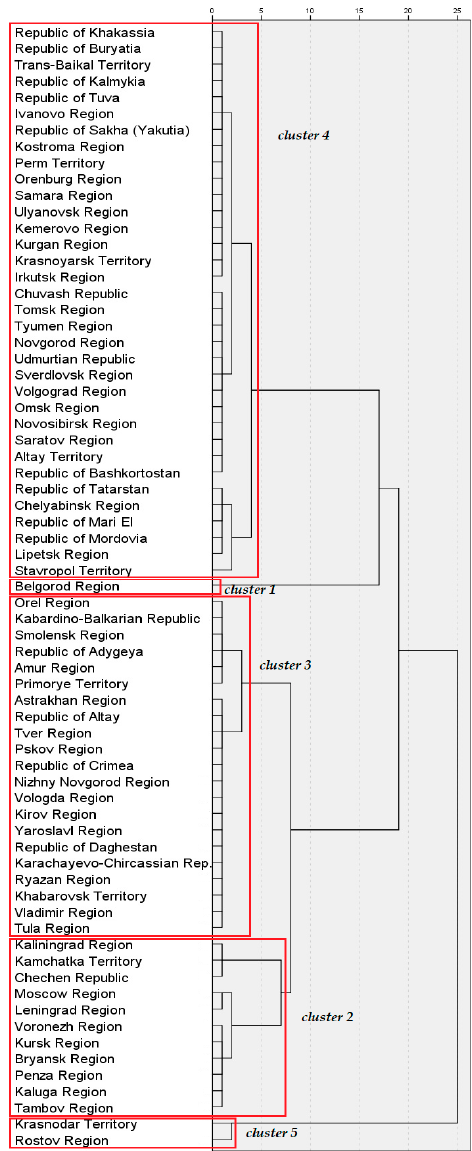
Figure 1. The hierarchical classification tree (dendrogram): Using the Ward method, with the Euclidean distance square as a measure.